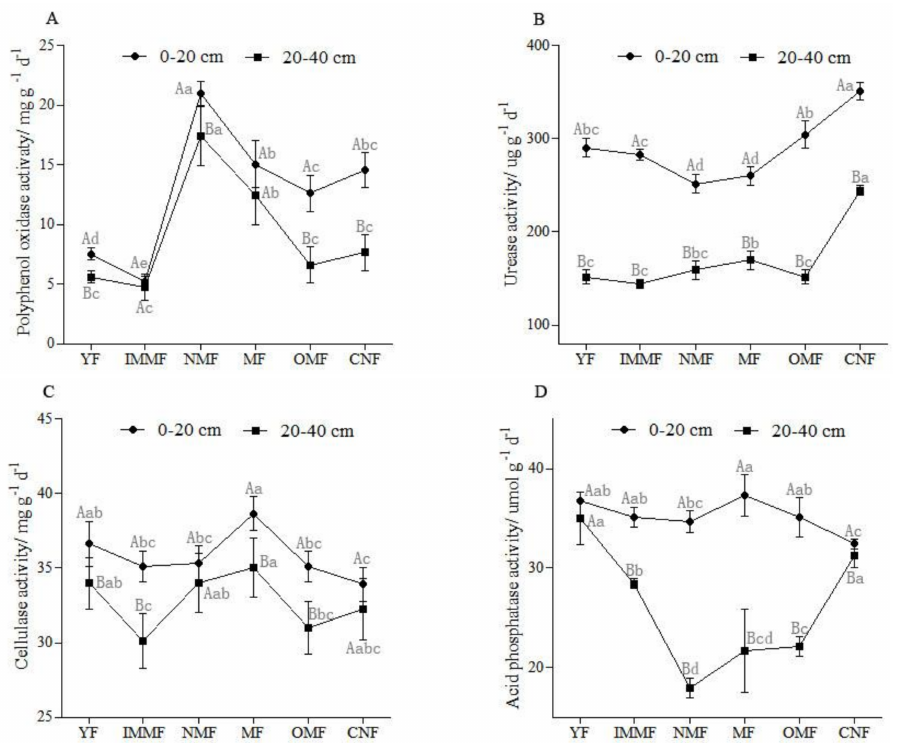
Figure 2. Soil enzyme activities at different stand ages. Different lowercase letters and different uppercase letters represent significant differences between the same soil depth of different stand ages and between different soil depths of the same stand ages ( p < 0.05), respectively. ( A ) polyphenol oxidase activity, ( B ) urease activity, ( C ) cellulase activity, and ( D ) acid phosphatase